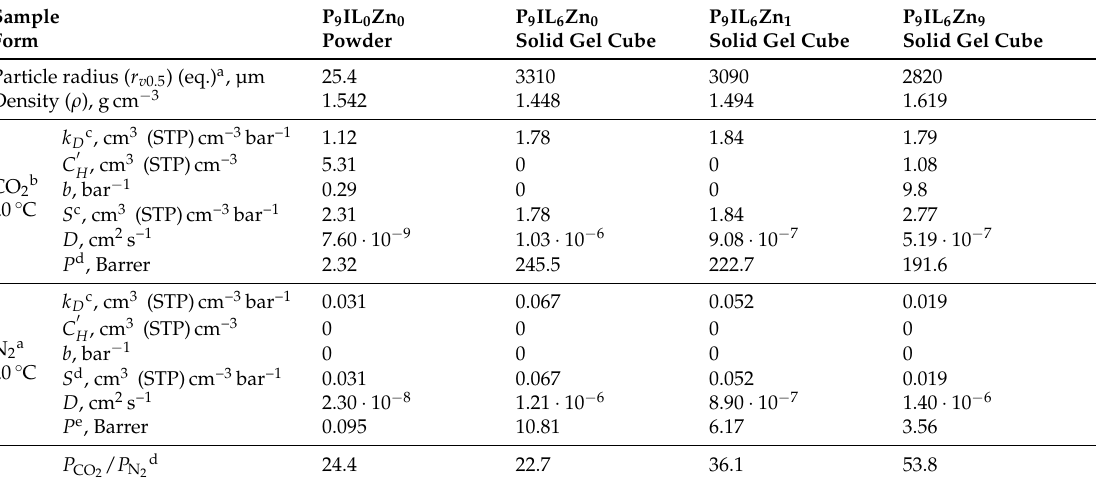
a The composite materials were thick solid gel discs that were cut into squares varying in size from 4.43mm to 5.39mm with equivalent radii given in the table. Therefore, r v 0.5 refers only to the pure poly(ionic-liquid) (PIL) sample. b Average relative error of 4.7%. c As all experimental data points lay in the non-linear sorption region the accuracy in the determination of k D may be compromised. d At 1bar. e Permeability was calculated indirectly from solubility